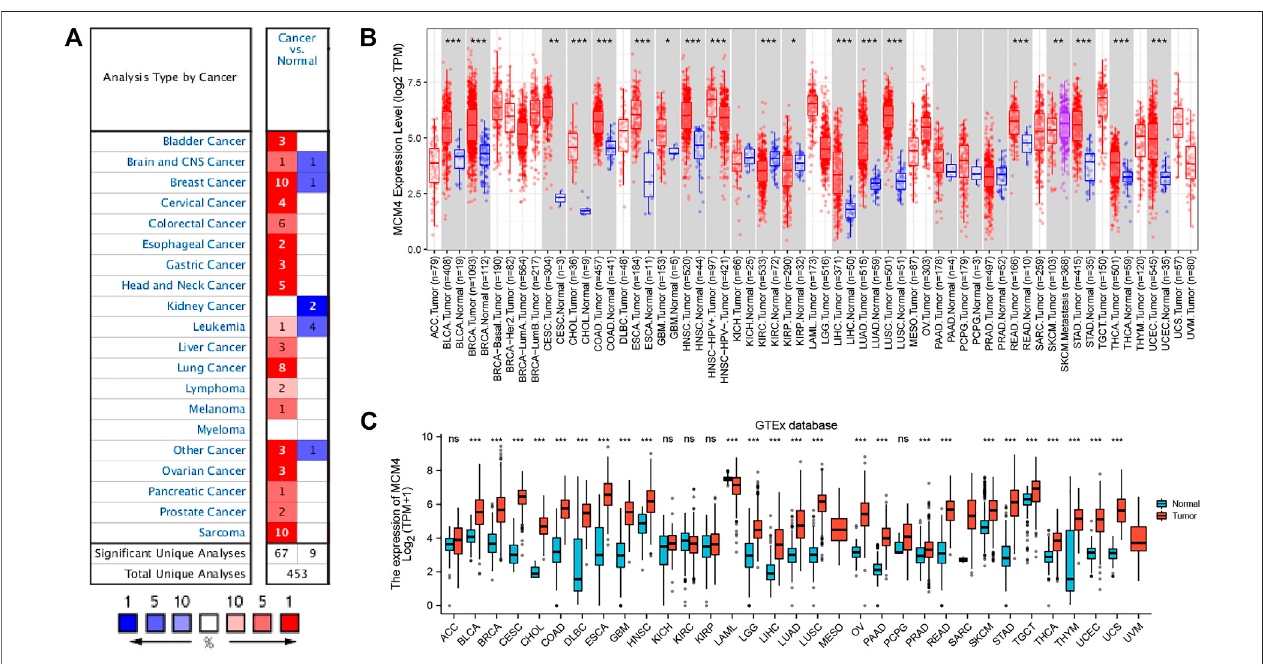
FIGURE1 | Expression level ofMCM4 gene in Pan-Cancer. (A) The expression level ofMCM4 gene indifferenttypes ofCancers(Oncominedatabase). (B) MCM4 expression in TCGA tumors and adjacent normal tissues (TIMER2.0 database). (C) MCM4 expression in TCGA tumors and normal tissues (GTEx database). *: p -value < 0.05; **: p -value < 0.01; ***: p -value < 0.001. TCGA, the cancer genome Atlas; TIMER, tumor immune estimation resource; GTEx, genotype-tissue